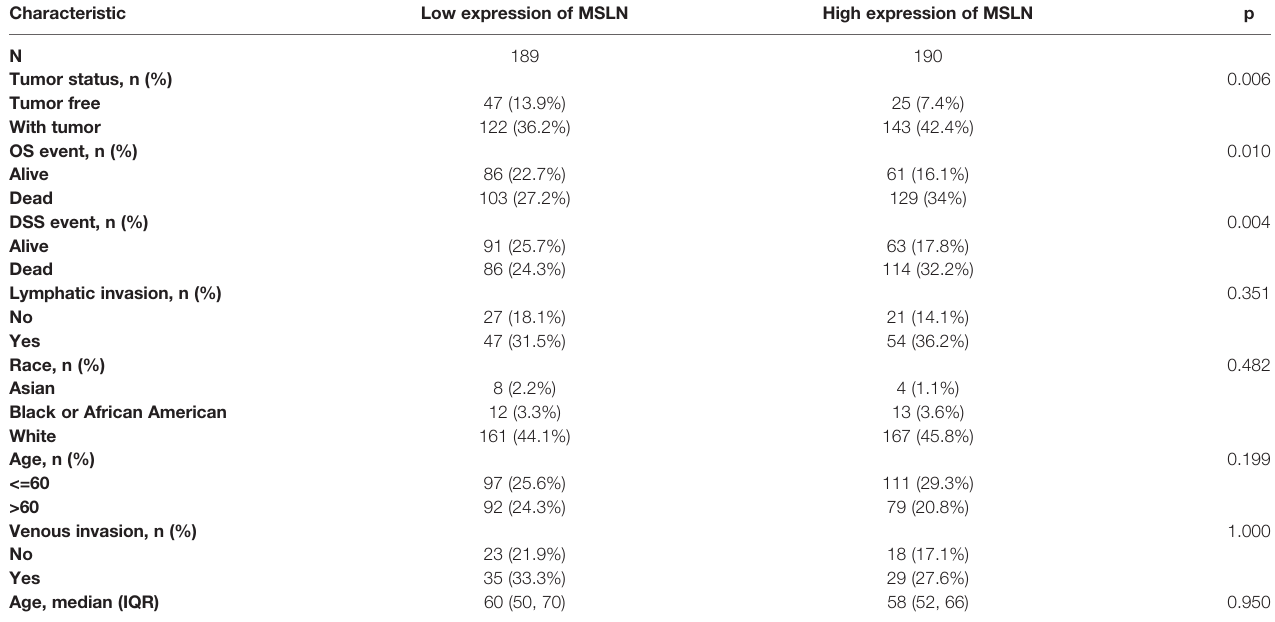
TABLE 1 | Clinical characteristics of ovarian cancer patients.